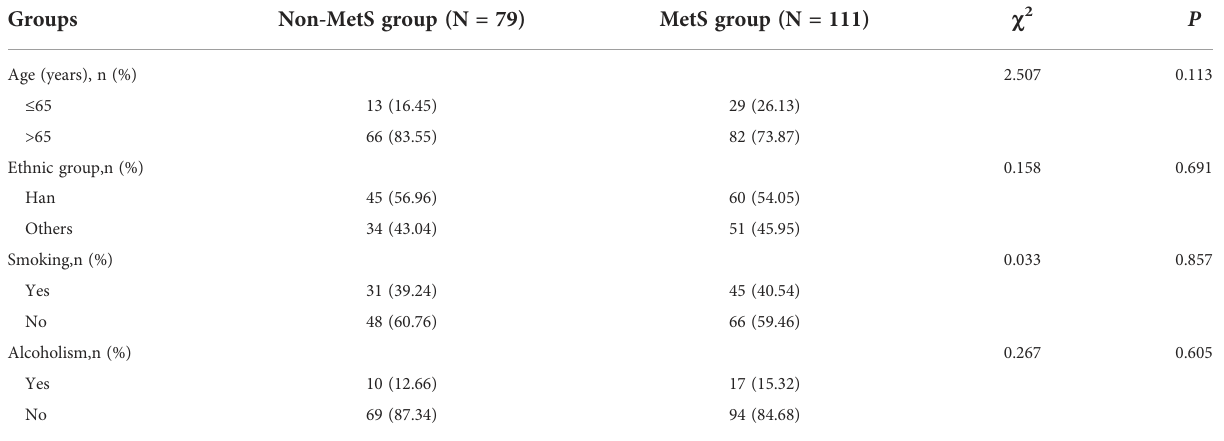
TABLE 1 Analysis of the general data between the Non-MetS group and MetS group.